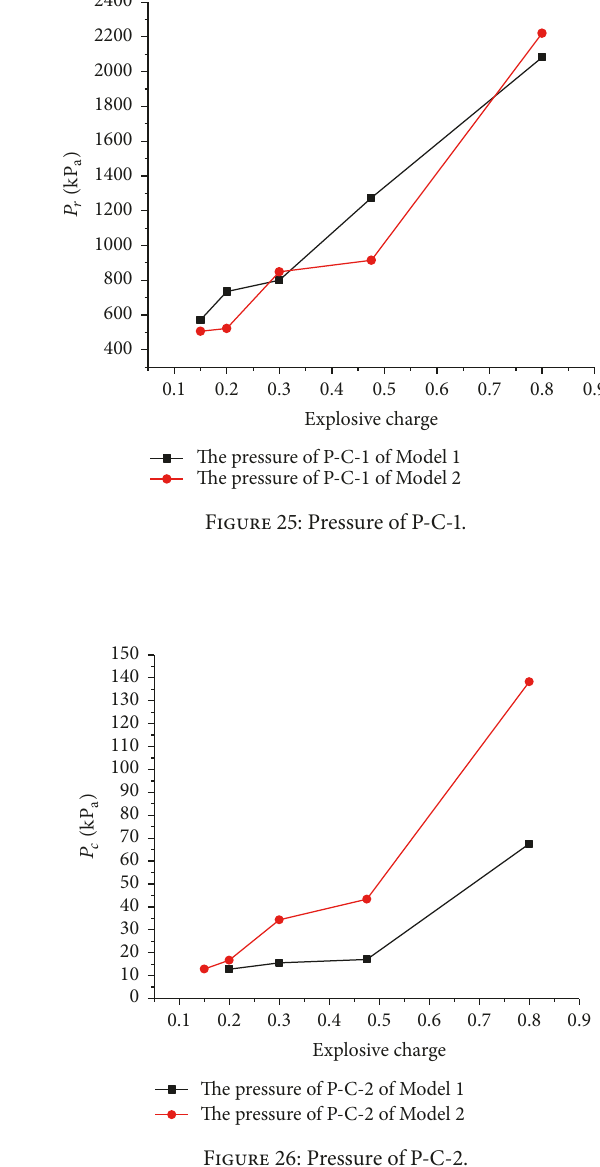
Figure 24: Pressure of P-B-2.